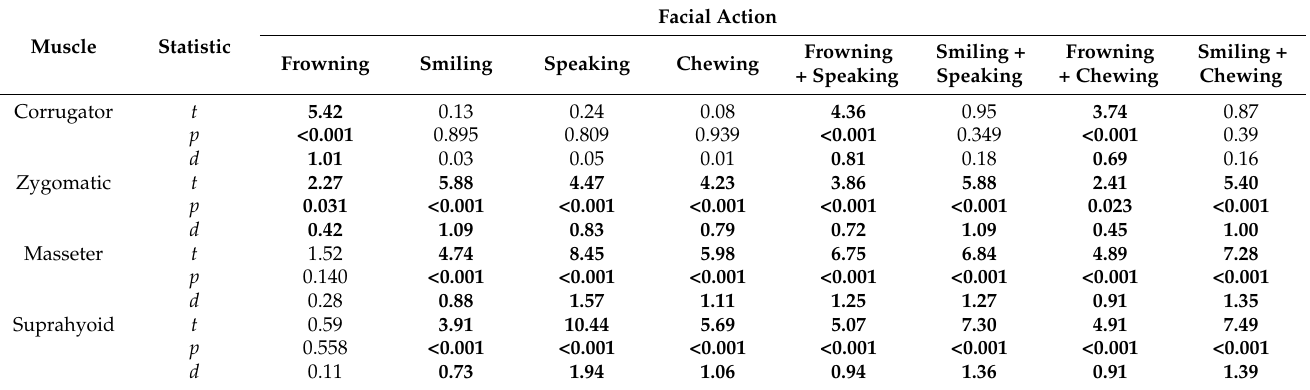
d , Cohen’s d statistic [47]. Degrees of freedom were 28 for all tests. Significant results ( p < 0.05) corrected using Holm’s method are shown in bold